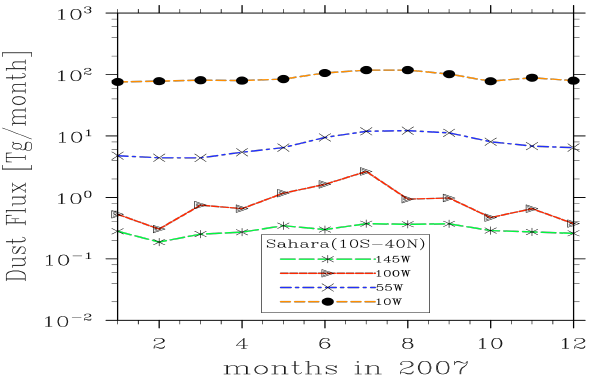
Fig. 2. Modeled monthly dust flux between 10 ◦ S–40 ◦ N, across different longitude planes (10 ◦ W, 55 ◦ W, 100 ◦ W, and 145 ◦ W) for Saharan dust in 2007.